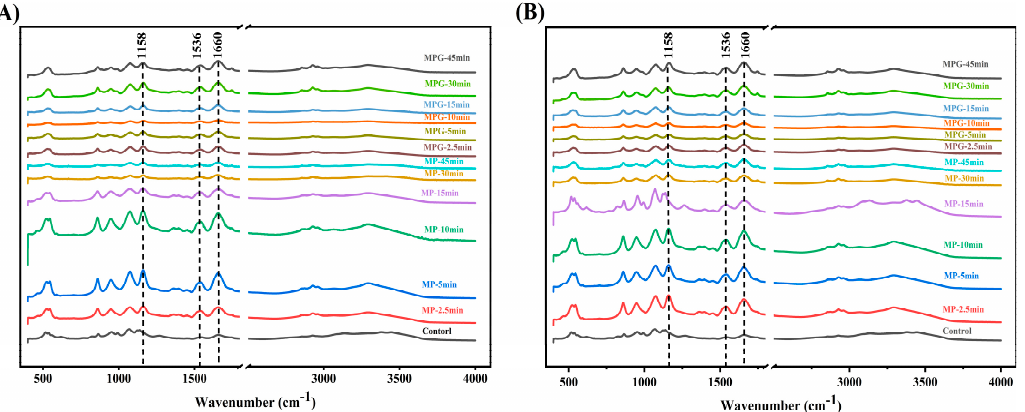
Figure 6. Changes in Fourier transform infrared spectroscopy of myofibrillar protein and glucose (MPG) and myofibrillar protein (MP) heated at 80 °C ( A ) and 98 °C ( B ) for 0 − 45 min.